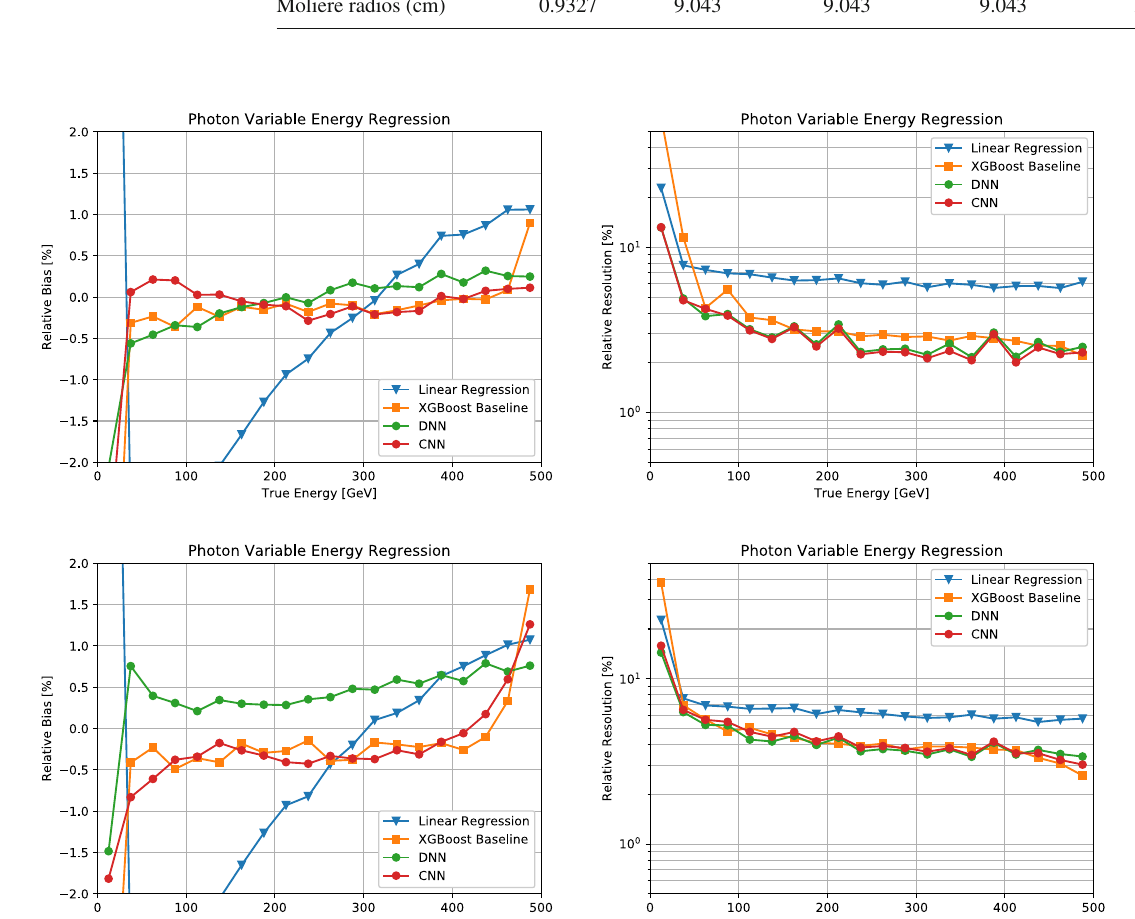
Fig. 18 Bias (left) and resolution (right) as a function of true energy for energy predictions for photons, on variable-angle samples resampled to ATLAS-like (top) and CMS-like (bottom) geometries